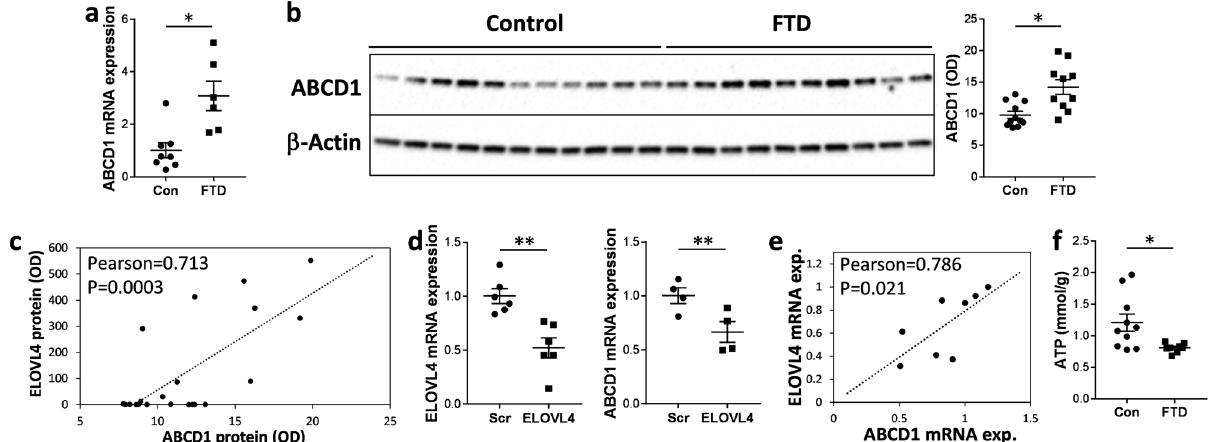
Figure 4. Upregulation of ABCD1 in response to high levels of VLCFA-lipids. ( a ) mRNA expression of ABCD1, normalized to the geometric mean of β-actin, GAPDH and PPIA, in superior frontal cortex of FTD brain (n = 10) and controls (n = 11) as measured by qPCR. Multivariate analysis (general liner model), co-varying for age and sex, was used to determine significance between the two groups. ( b ) Protein expression of ABCD1 in superior frontal cortex of FTD brain (n = 10) and controls (n = 11) as measured by western blotting and optical density (OD) measurement of the protein bands normalized to β-actin. Multivariate analysis (general liner model), co-varying for age and sex, was used to determine significance between the two groups. ( c ) ABCD1 protein (OD) correlated significantly with the 37-kDa ELOVL4 protein (OD) as determined by Pearson correlation coefficient. ( d ) SH-SY5Y neuronal cells were knocked down with ELOVL4 siRNA or scramble control (Scr) siRNA (n = 4 each; 3 experimental repeats), and ELOVL4 and ABCD1 mRNA expression, normalized to the geometric mean of β-actin, GAPDH and PPIA, assessed by qPCR. Student’s t -test was used to determine significance between the two groups. ( e ) ABCD1 mRNA expression correlated significantly with ELOVL4 mRNA expression in the SH-SY5Y neuronal cells as determined by Pearson correlation coefficient. ( f ) ATP levels were significantly decreased in FTD brain (n = 10) compared to controls (n = 11). Multivariate analysis (general liner model), co-varying for age and sex, was used to determine significance between the two groups. Data represent mean and SE as error bars, * P < 0.05, ** P < 0.005.